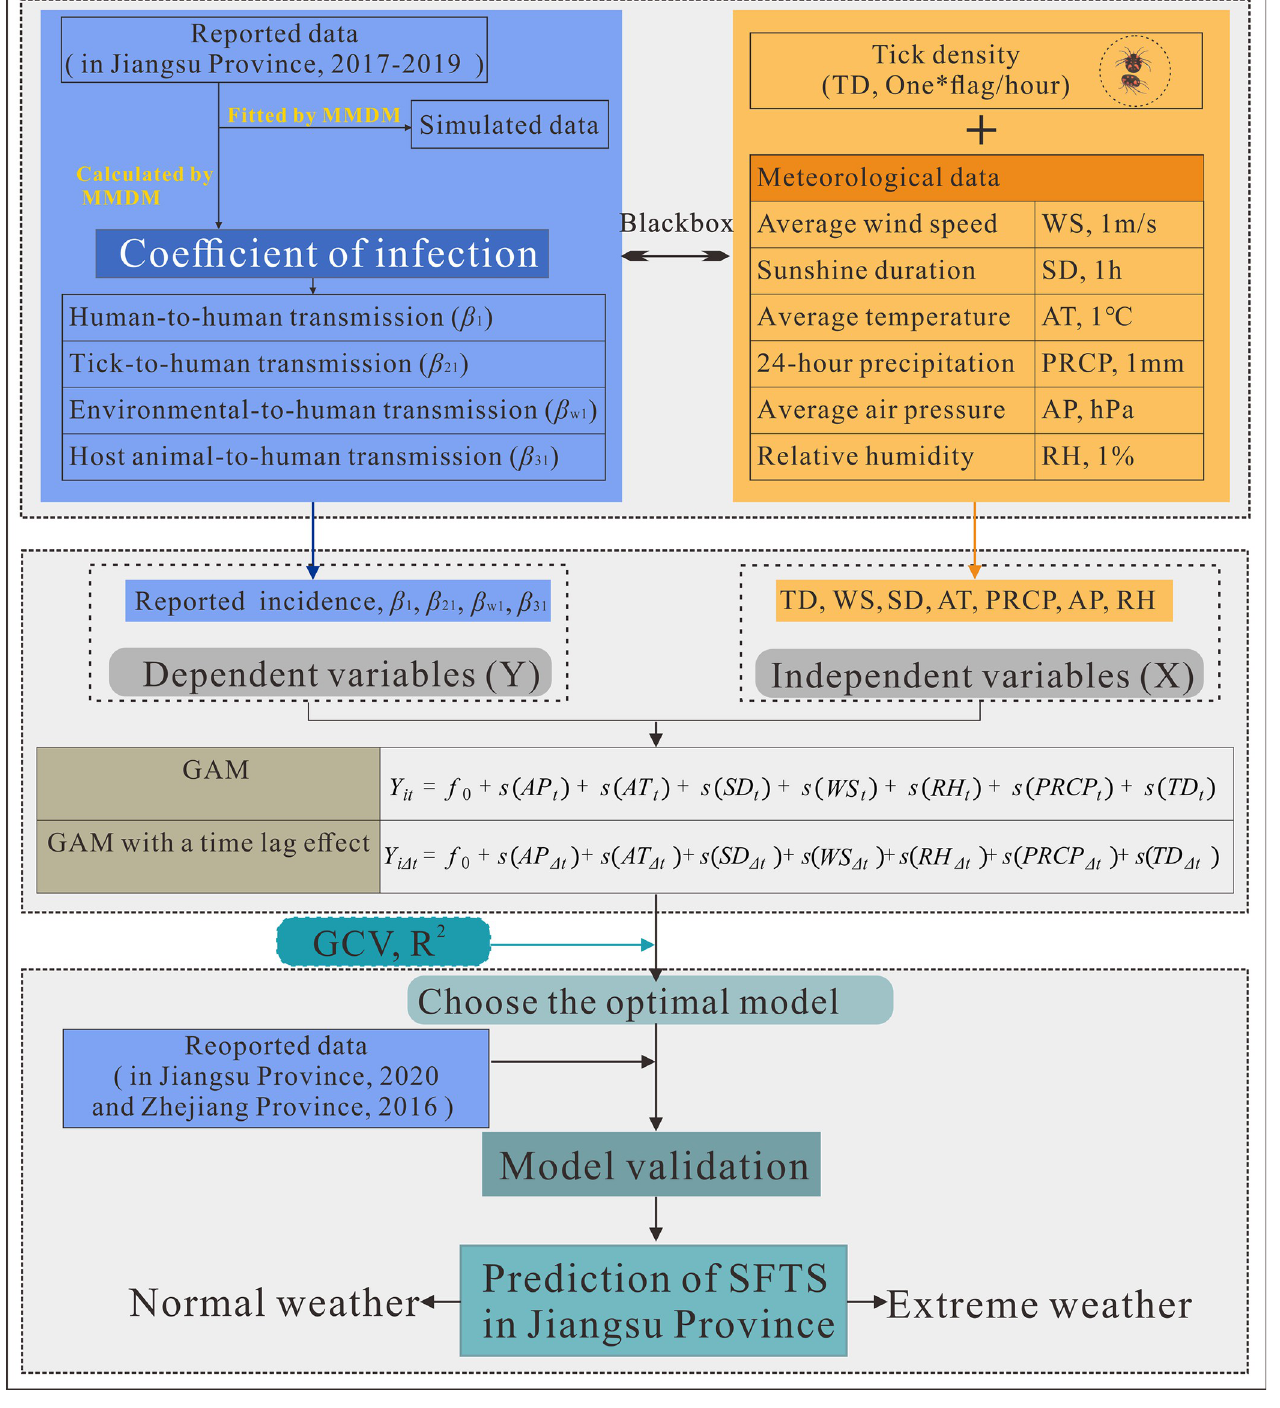
PLOS NeglectedTropical Diseases | https://doi.org/10.1371/journal.pntd.0010432 May 9, 2022 5 /